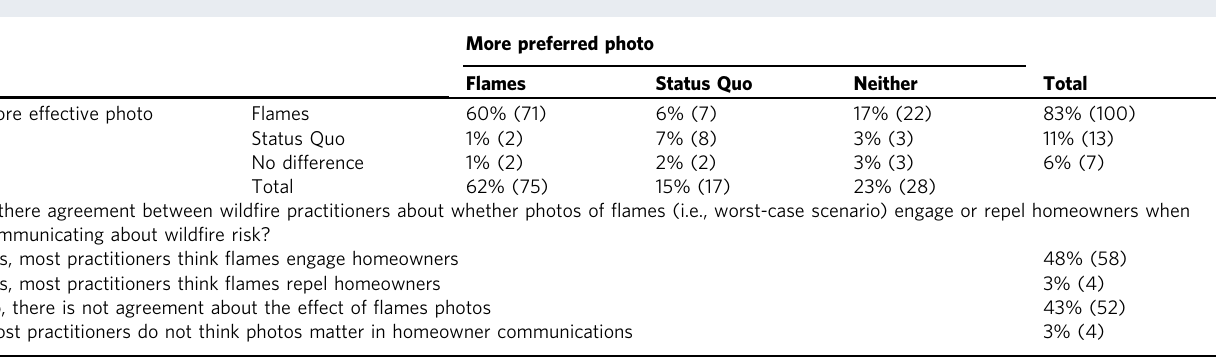
Table 1 Responses to wild fi re practitioner